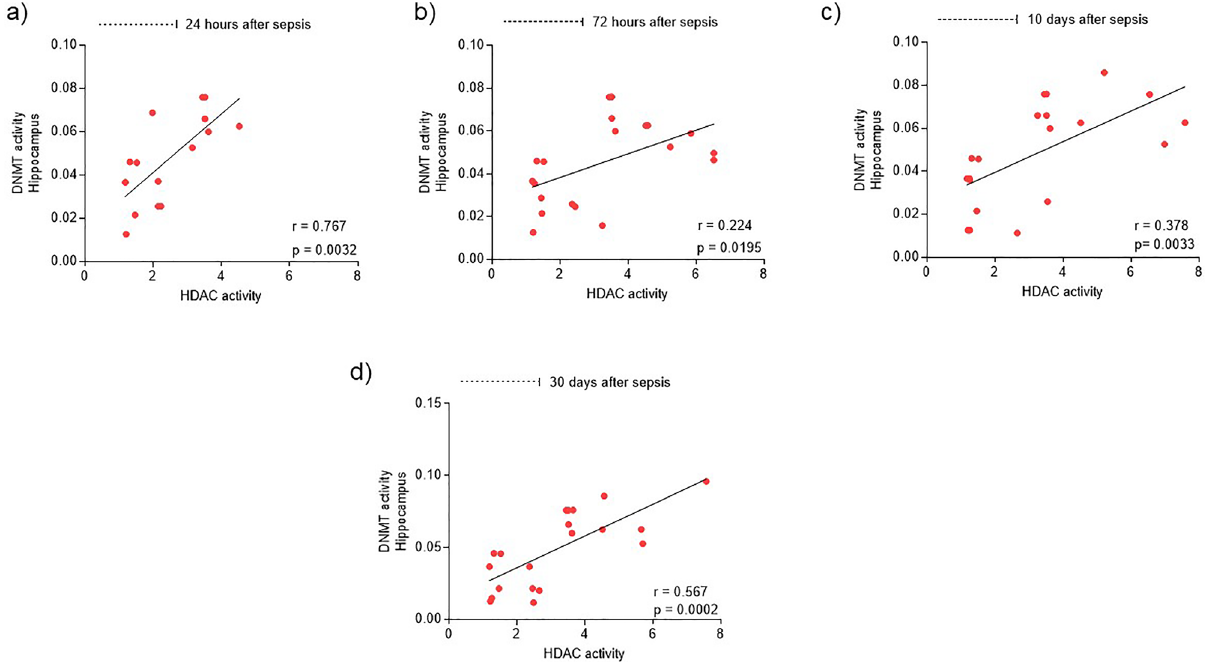
Figure 5. Correlation of the activity of epigenetic enzymes DNMT and HDAC in the hippocampus of animals submitted to sepsis. DNMT and HDAC activities were correlated in the hippocampus tissue of animals submitted to sepsis at different times. 24 h ( a ); 72 h ( b ) 10 days ( c ); 30 days ( d ). Data are expressed using Pearson’s correlation coefficient, considering the value of “r”.